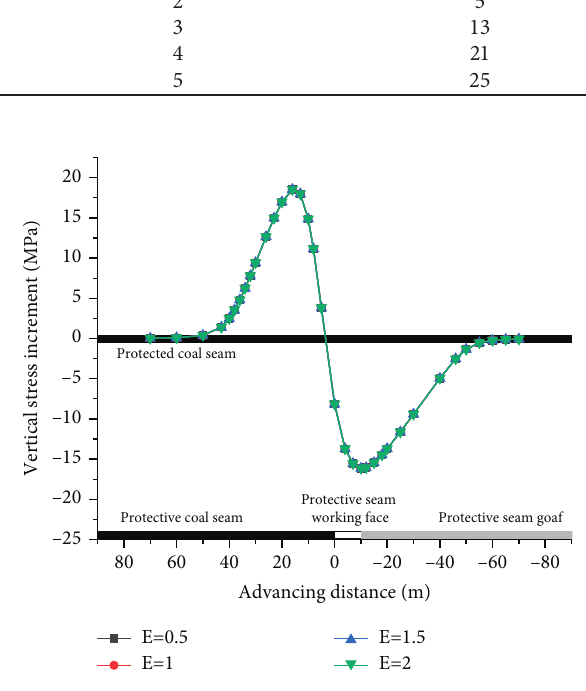
Figure 6: Different elastic modulus stress change curves.